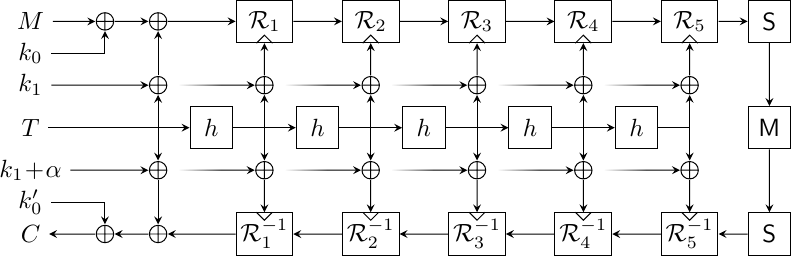
Figure 1: PRINCE -like structure of MANTIS r , illustrated for MANTIS 5